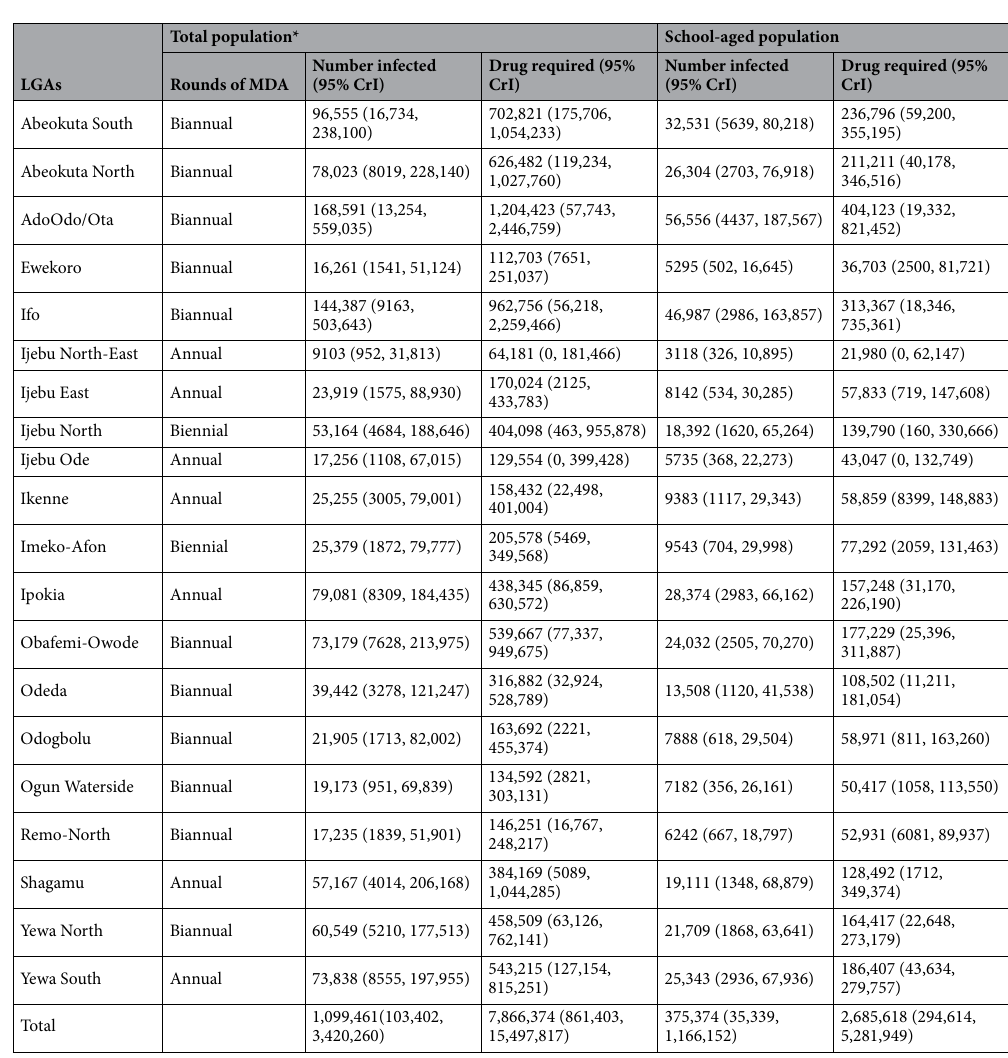
Table 5. Estimates of number of people infected and annual drug requirements in Ogun State, Nigeria. *Total population comprises of preschool-aged children, school-aged children and adults; CrI : Credible